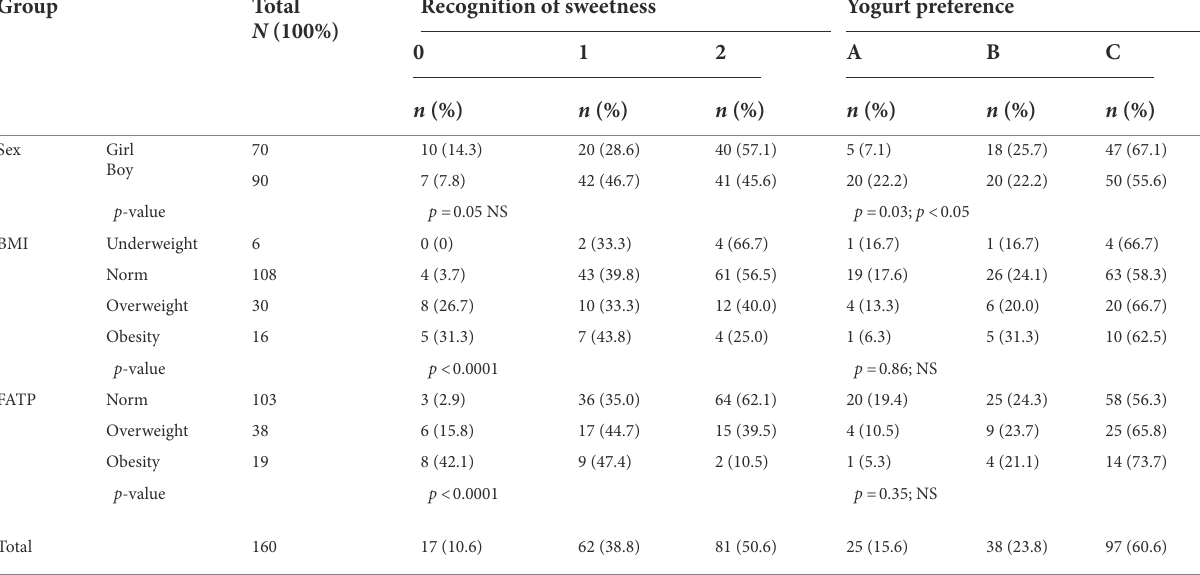
TABLE 4 Results of the sweetness recognition test and yoghurt preference, taking into account the sex, BMI and FATP of the respondents.